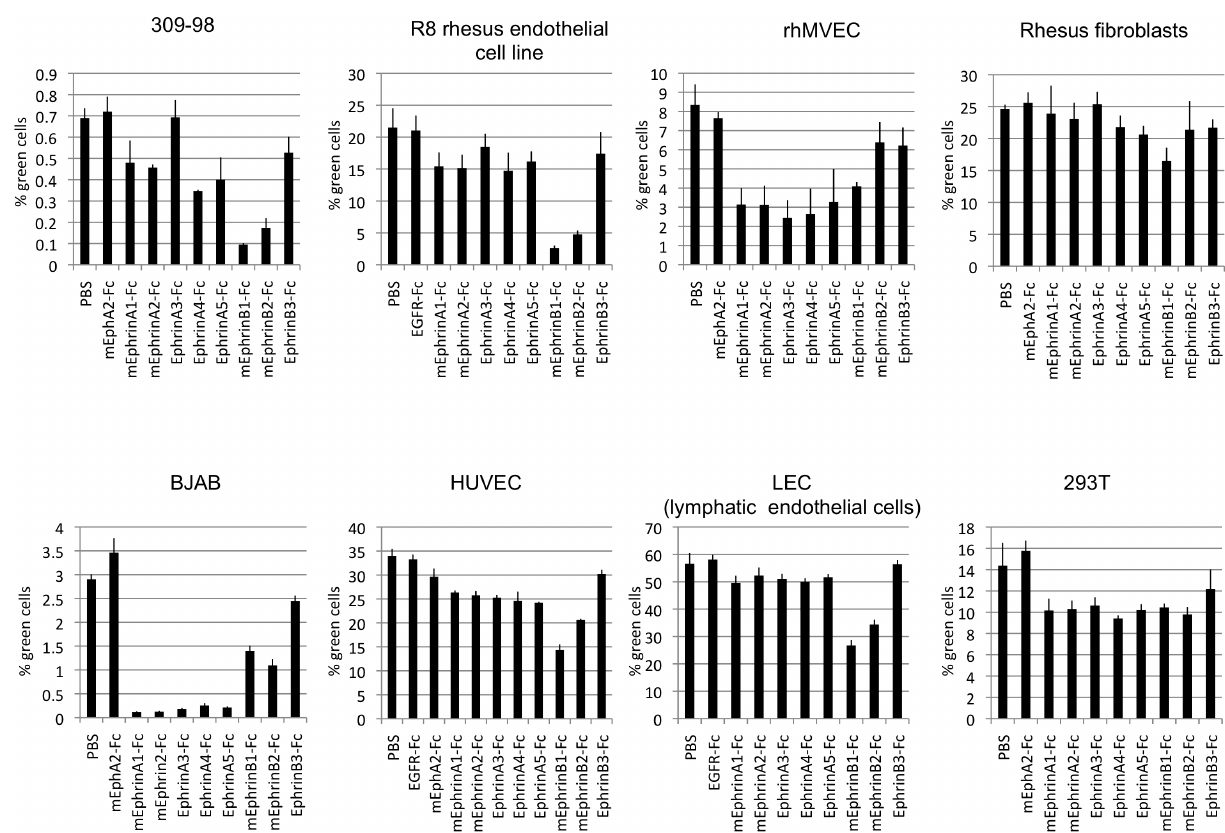
Figure 4. Block of RRV entry by soluble Ephrins. Primary cells and cell lines were incubated with the soluble Ephrin-Fc fusion proteins at 5 m g/ ml for 30 minutes prior to infection with GFP encoding RRV 26-95. Entry was quantified by flow cytometry. EGFR-Fc or mEphA2-Fc were used as controls in addition to PBS. (n=4 for rhMVEC , LEC, and R8, else n=3; error bars indicate sd).